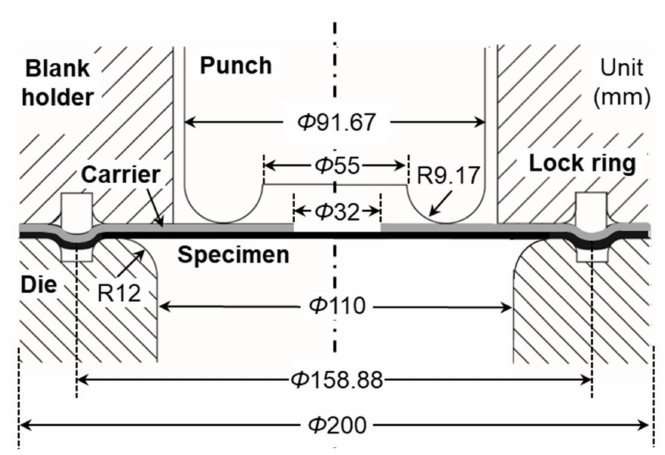
Figure 13. Cross-sectional view of the tooling used for Marciniak FLC experiments, showing the flat punch, die, blank holder, lock ring, and the specimen and carrier blanks.